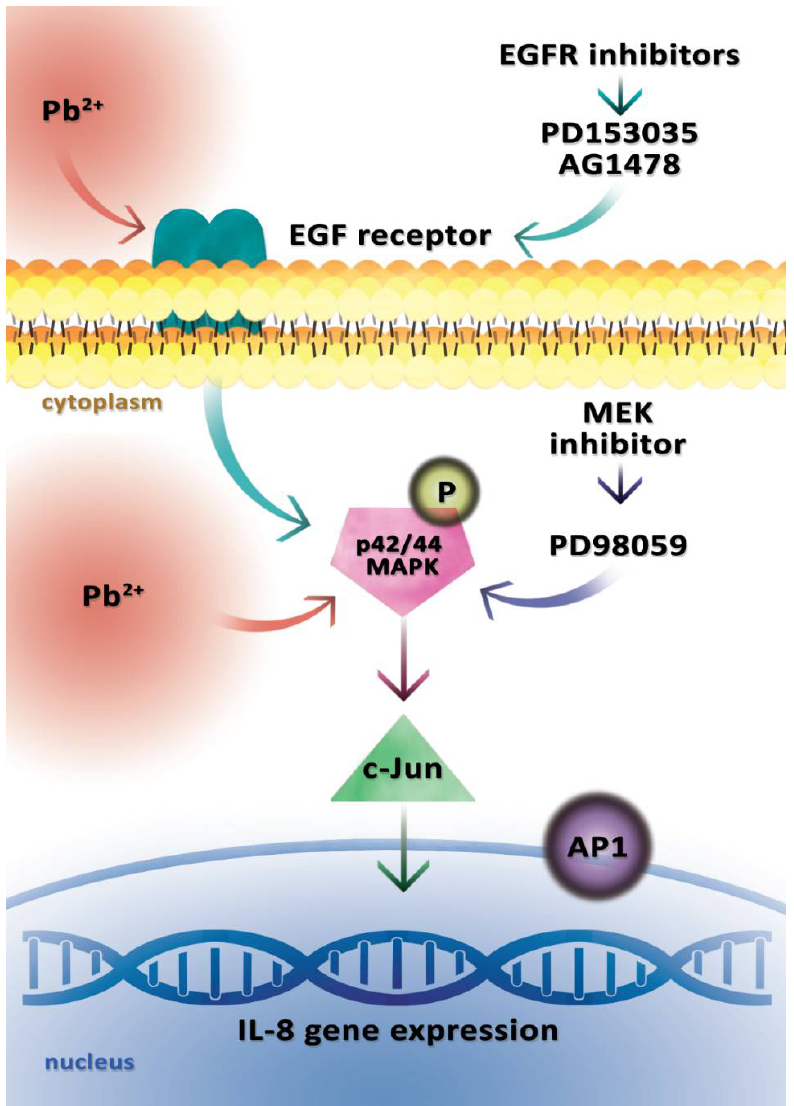
Figure 1. Model of lead (Pb 2+ )-induced activation of the IL-8 gene. The diagram presents a signaling pathway leading to the induction of the IL-8 gene in human AGS cells (human caucasian gastric adenocarcinoma) after the administration of 0.1 μM Pb(NO 3 ) 2 . Pb 2+ activates the epidermal growth factor receptor (EGFR) and p42/44 mitogen activated protein (MAP) kinase phosphorylation, which then activates the protein heterodimeric transcriptional factor AP-1 (containing the c-jun protein), resulting in the activation of IL-8 gene expression. The use of EGFR inhibitors (PD153035 and AG1478) resulted in a decrease in IL-8 gene expression, but EGFR inhibitors were unable to fully abolish Pb(NO 3 ) 2 -induced IL-8 gene expression. The use of a MAP kinase kinase (MEK) inhibitor (PD98059) significantly suppressed IL-8 gene expression.